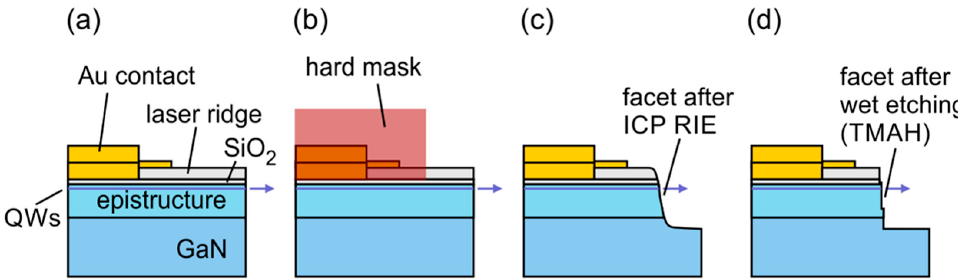
Figure 2. Schematic representation of the processing steps: ( a ) Epitaxial structure processed in the conventional way [20], ( b ) preparation of the hard mask used to deep etch the laser facet using RIE, ( c ) cross-section after the dry etching procedure with an exaggerated sloped facet, ( d ) device after the optimal wet etch step with a fully formed facet.